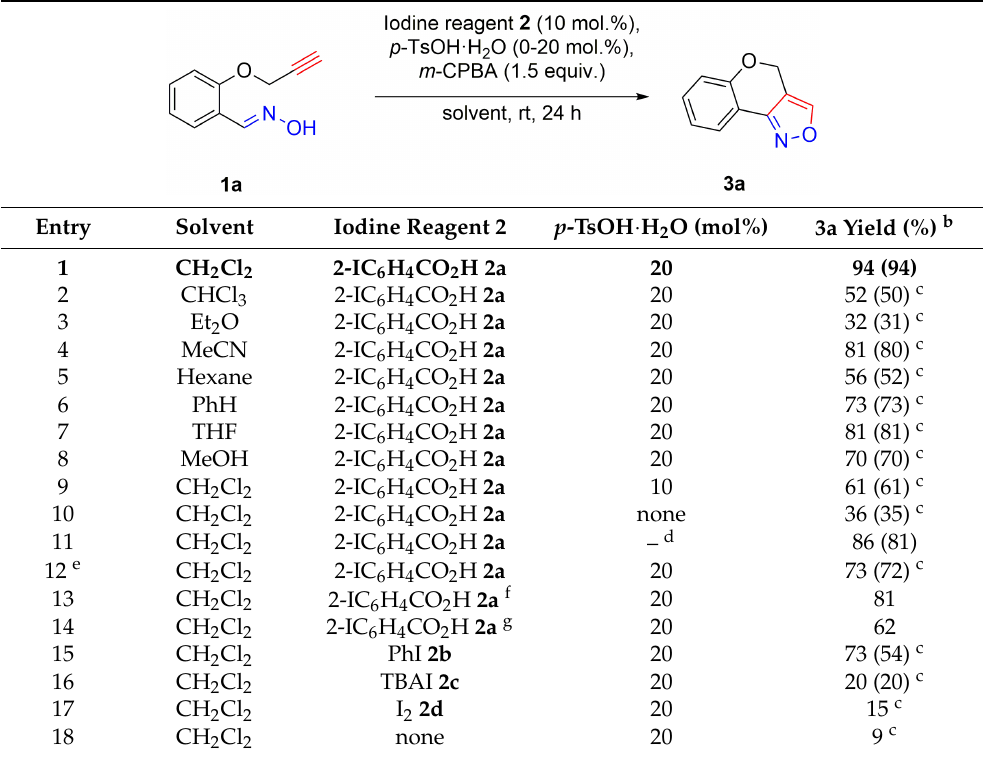
Table 1. Optimization of the catalytic intramolecular cycloaddition of aldoxime 1a a .